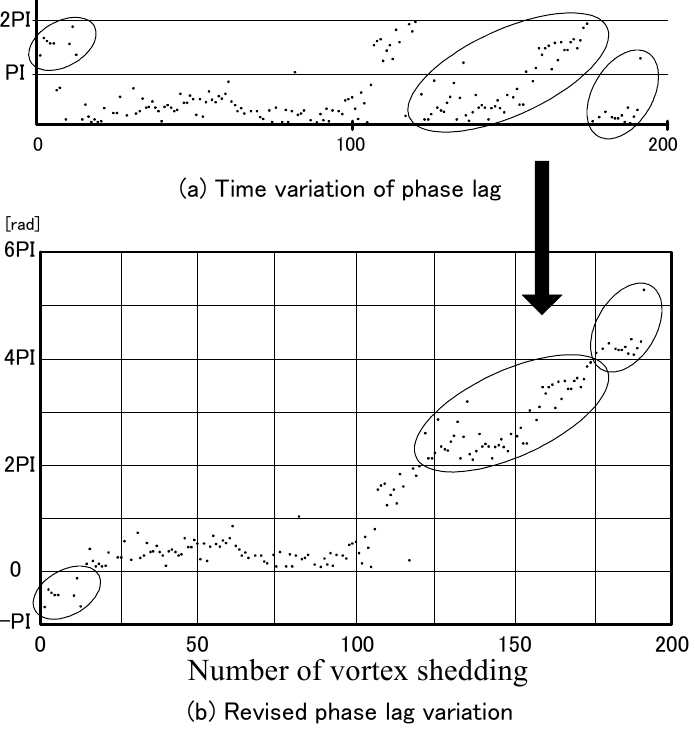
Fig.6 Revision of phase lag variation with time (